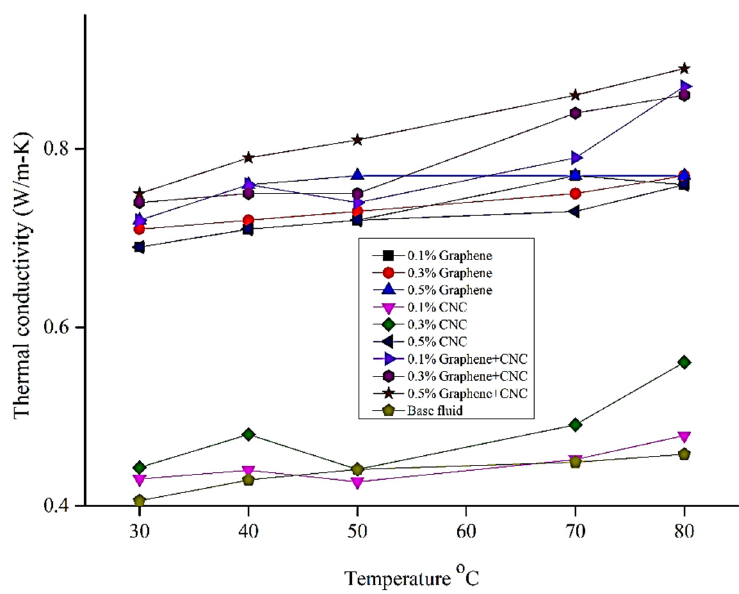
Figure 13. Graphene, CNC, and hybrid nanofluid thermal conductivity at a range of temperatures.